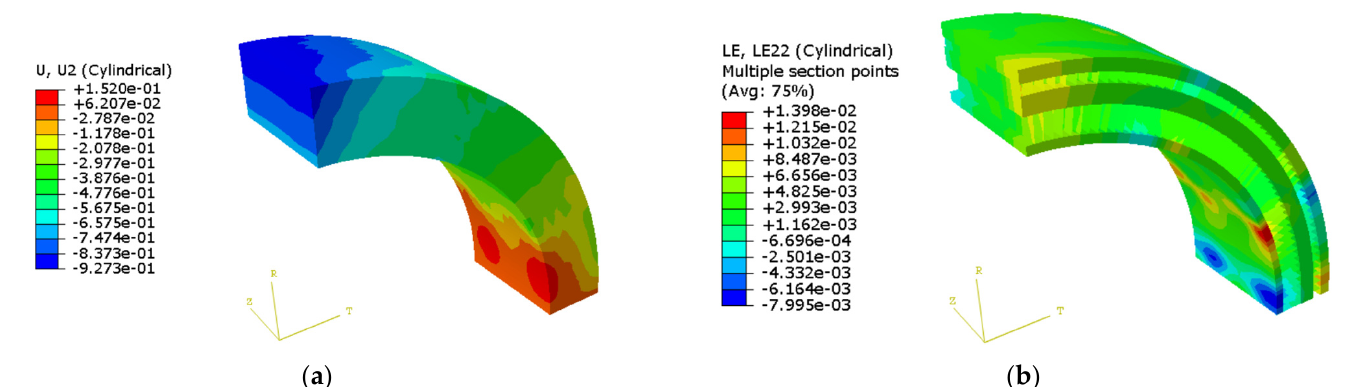
Figure 12. Result of the simplified FE model: ( a ) circumferential displacement; ( b ) circumferential strain.